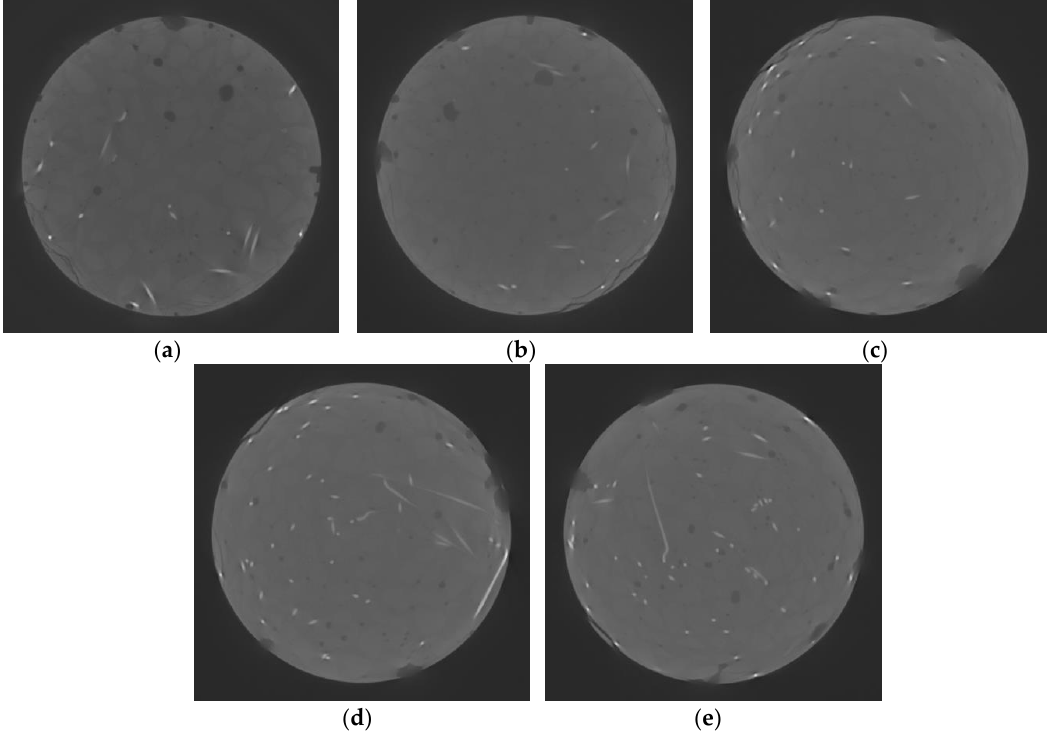
Figure 16. Examples of cracking in specimens of SFHPC. H-Series under the five different sets of cycles: ( a ) 0 cycles; ( b ) 2000 cycles; ( c ) 20,000 cycles; ( d ) 200,000 cycles; ( e ) 2,000,000 cycles.